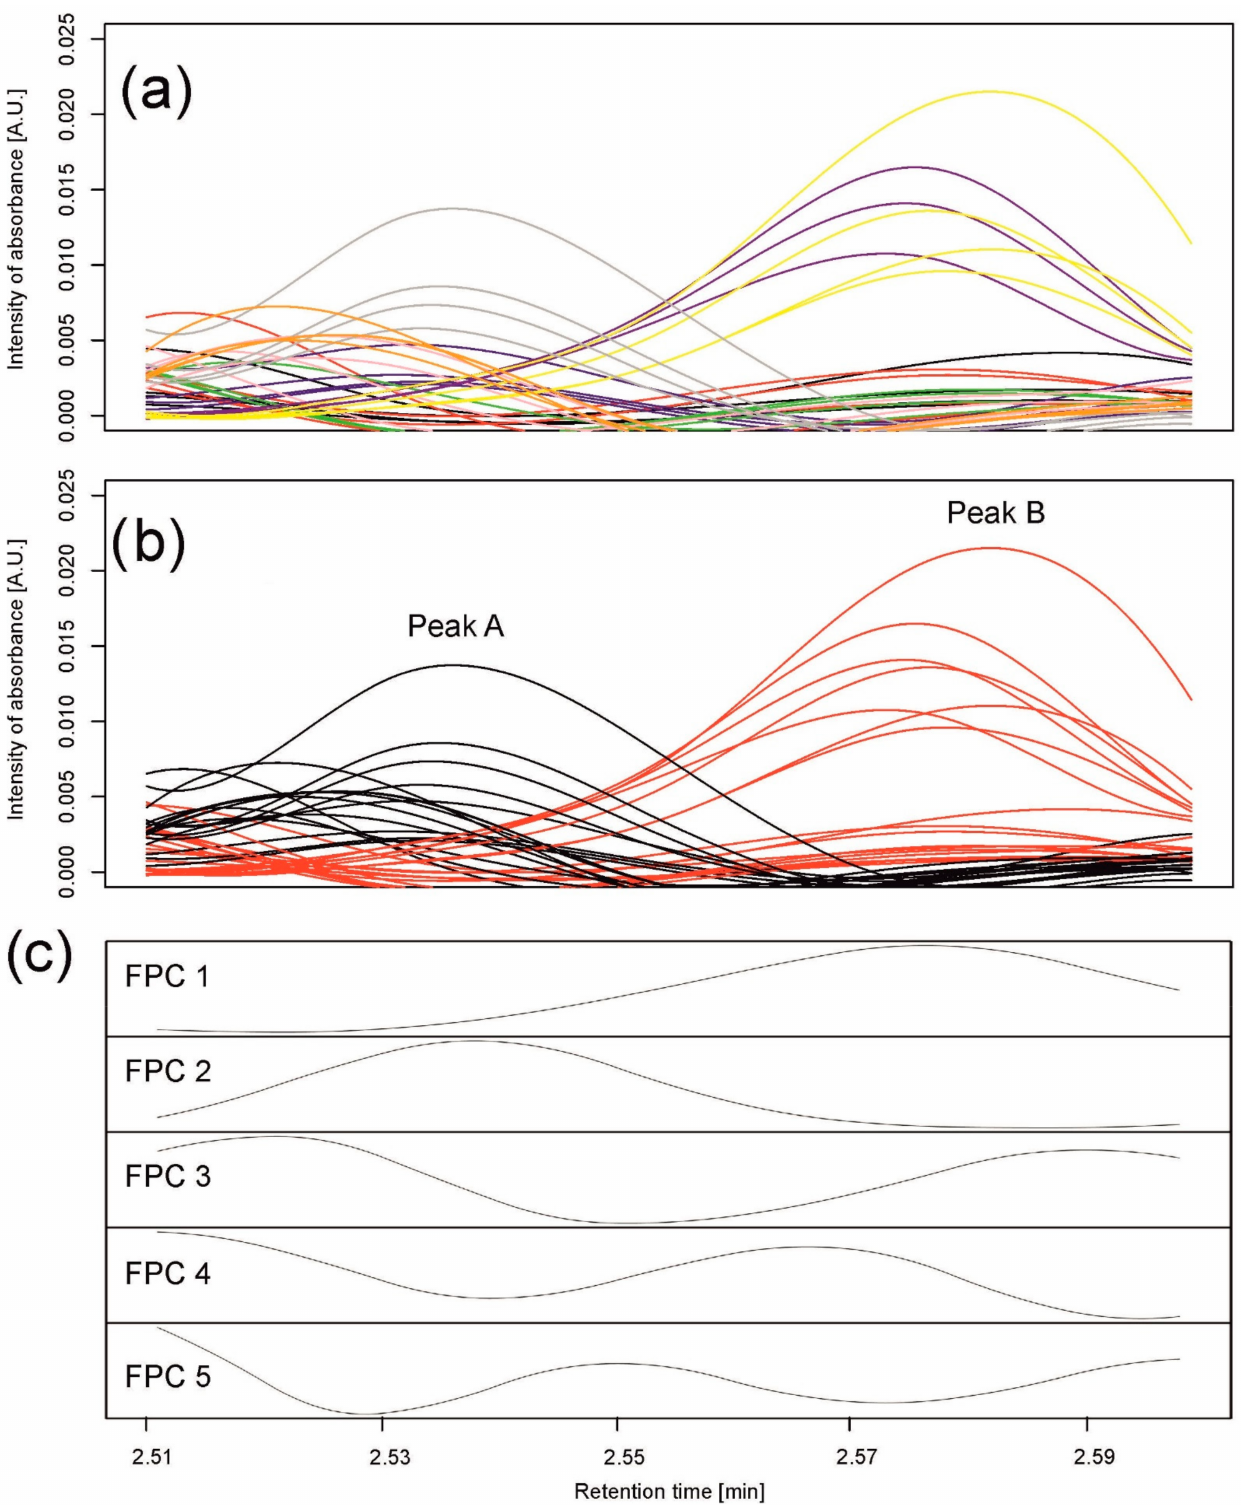
Figure 4. Data analysis for peaks observed in barley samples taken on the 6th day of the drought variant I for wavelength 280 nm. ( a ) Observed chromatograms; colors indicate varieties: black—Maresi; red—Lubuski; blue—Georgia; green— Harmal: pink—Cam/B1/CI; purple—MDingo; yellow—Morex; gray—Sebastian; and orange—Stratus. ( b ) Observed chromatograms; colors indicate two clusters obtained by Method 1. ( c ) First five eigenfunctions obtained by Method 2 accounting for 99.93% of the total variance. Functional principal component 1 (FPC1) (76.88% of the variance) corresponds to peak (cluster) B, and the component FPC2 (18.32% of the variance) to peak (cluster)